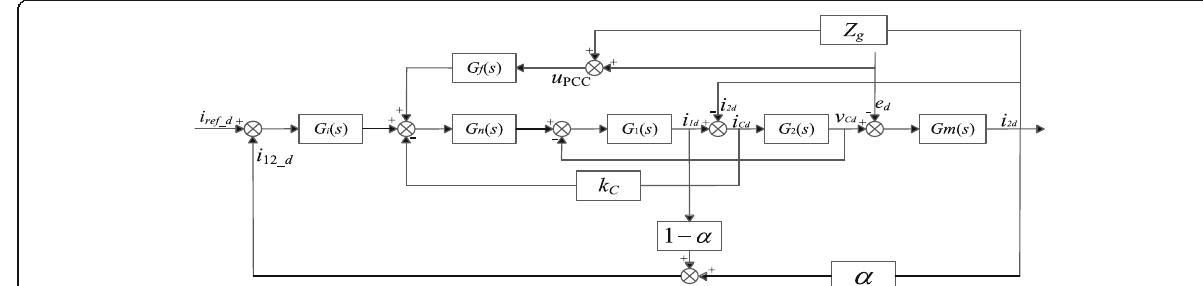
Fig. 7 An improved weighted average current control method in weak current network